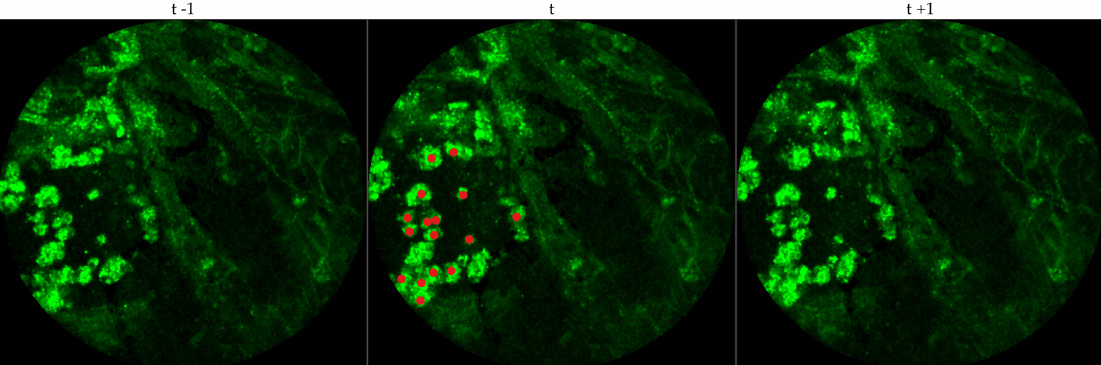
Figure 3. FCFM image frame with annotated bacteria shown as circles at time t .